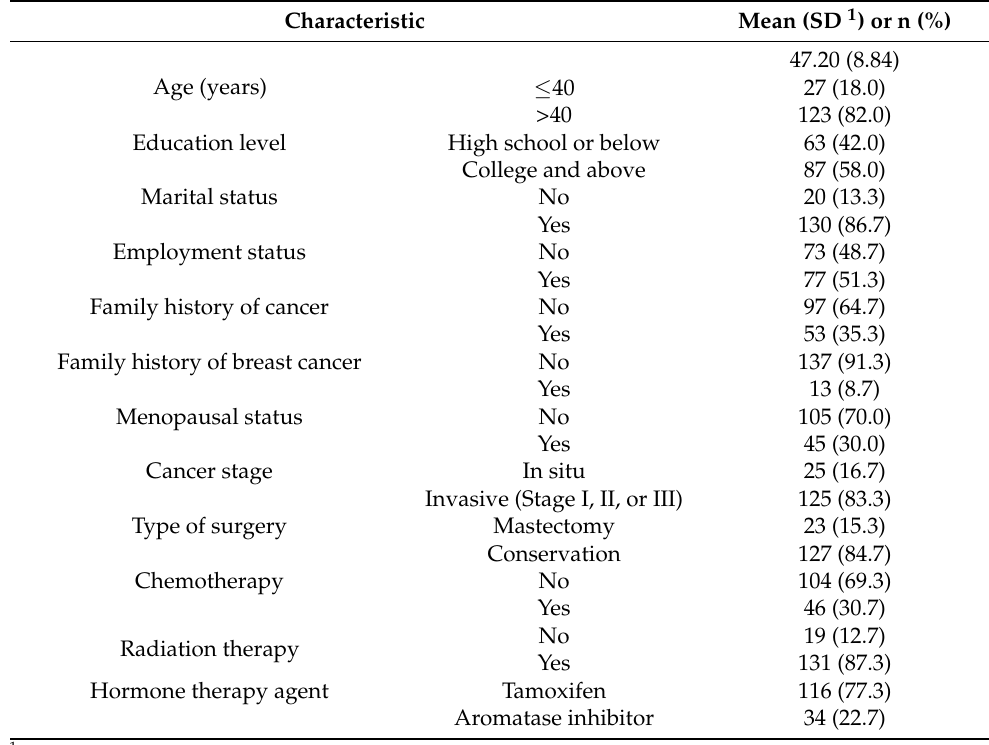
Table 1. Demographic and clinical characteristics of the patients (n =